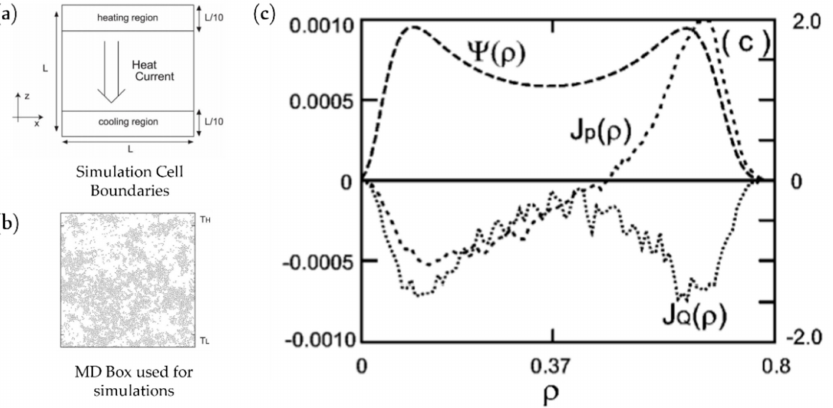
Figure 9. ( a ) MD cell under vertical heat flow, ( b ) snapshot of MD particles at n = 0.37 in a